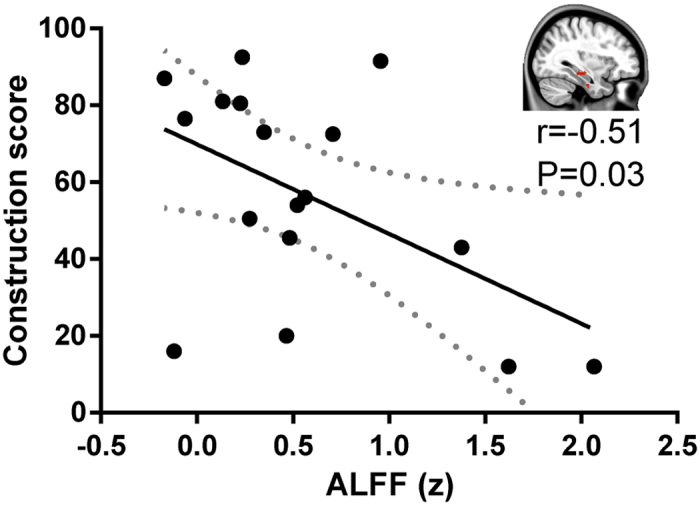
Correlation between ALFF and clinical scores in aphasic patients.ALFF values in the right hippocampus/parahippocampus were negatively correlated with construction scores in the Aphasia Battery of Chinese (r = −0.51, p = 0.03). The solid line and dashed lines represent the best-fit line and 95% confidence interval of Pearson correlation, respectively.